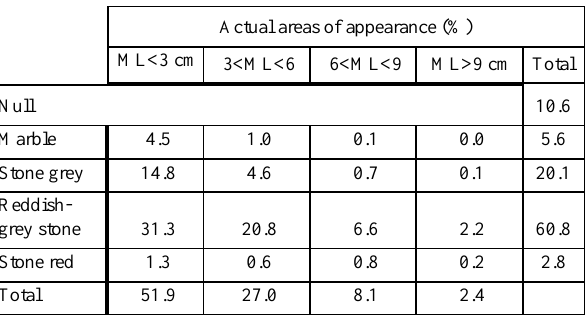
Table 2. Cross classification matrix between the building material classes and the material loss (ML) classes for the St. Nikolas Fort test area.